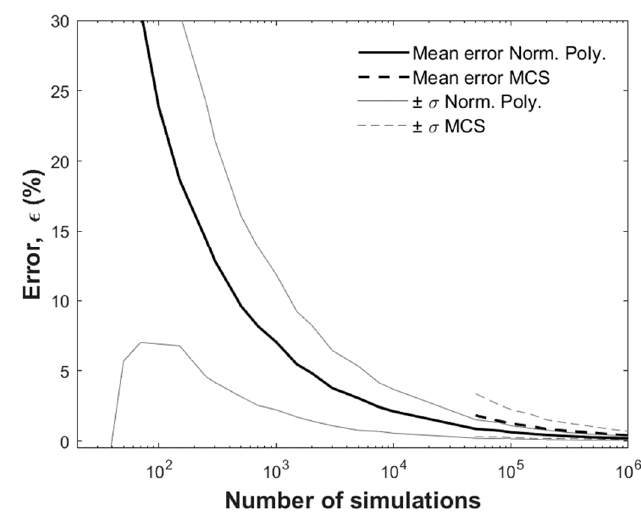
Figure 2. Deviations from the exact reliability index as percentage error.